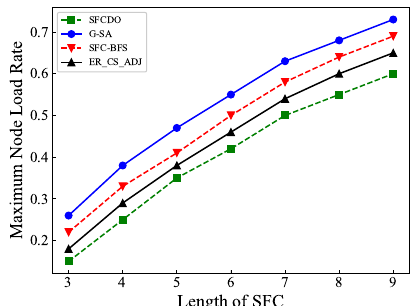
Figure 9. Maximum node load rate of SFCs in small topology.